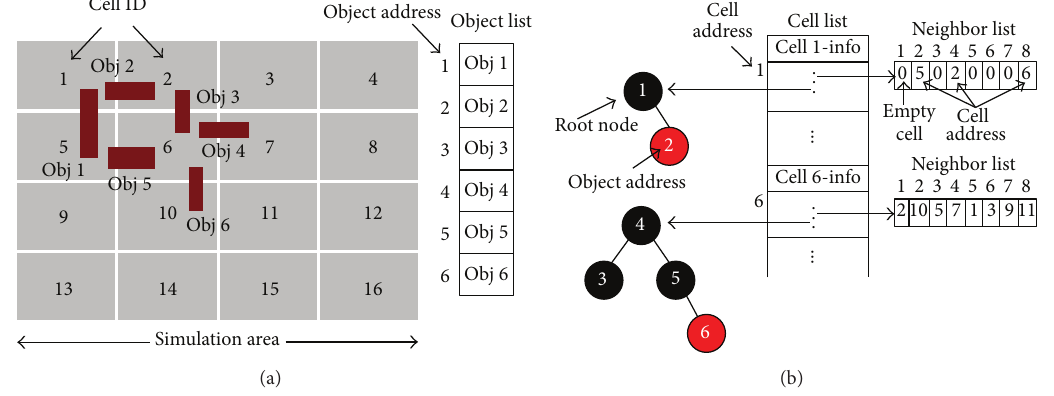
neighbor, third one is the left, fourth one is the right, fifth one is the top-left, sixth one is the top-right, seventh one is the bottom-left, and eighth one is the address of the bottom- right neighbor. In case of cell 1, first, third, fifth, sixth, and seventh position of the neighbor list hold “zero” value, which means cell 1 has no top, left, top-left, top-right, and bottom- left